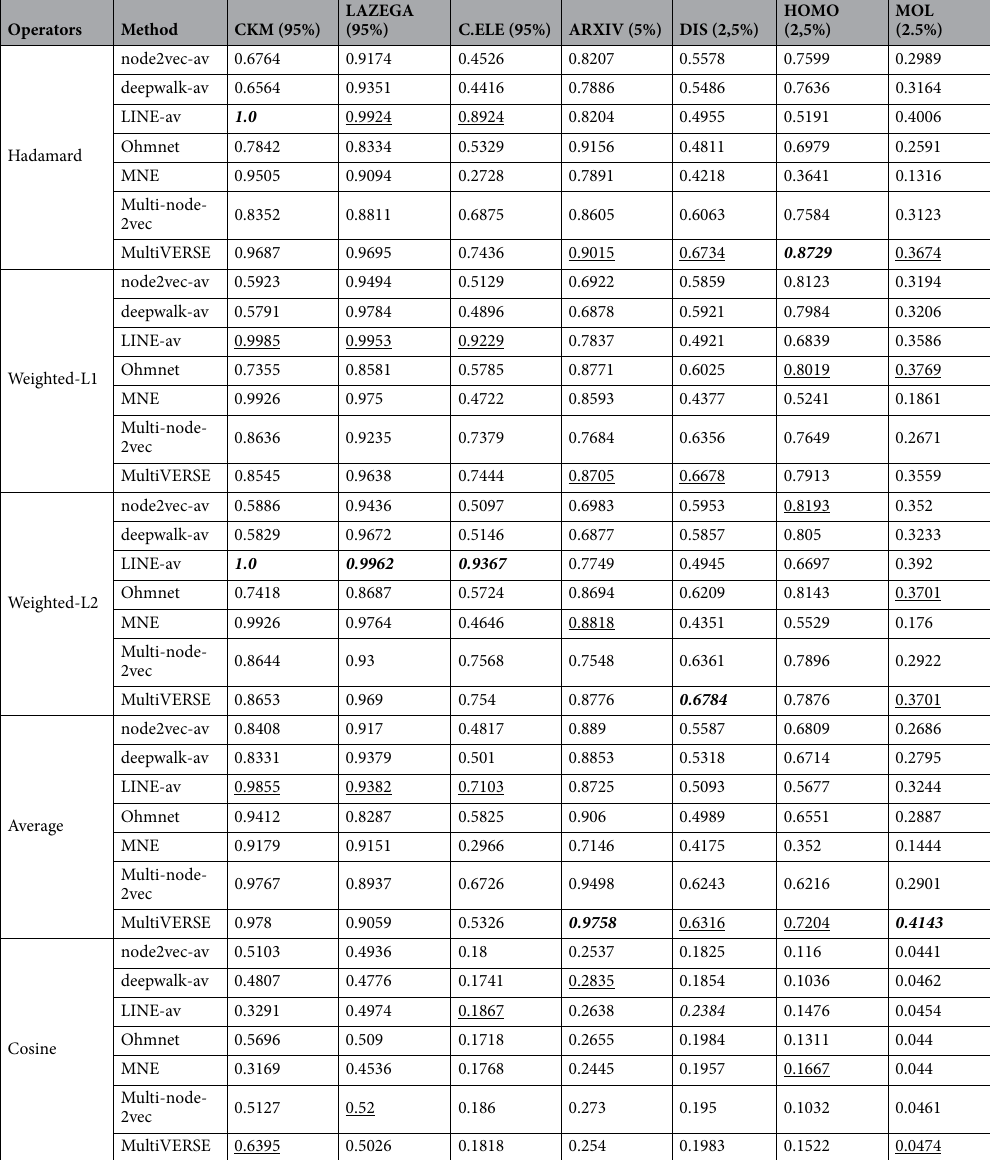
Table 5. precision@ K scores for network reconstruction on the 7 reference multiplex networks, for the network embedding methods combined with different embeddings operators (Hadamard, Weighted-L1, Weighted-L2, Average, and Cosine). For each multiplex network, the best score is in bold; for each operator, the best score is underlined. The percentage of edges used for the reconstruction is indicated in parenthesis under the name of the network. In the case of large networks (DIS, ARXIV, HOMO and MOL) MultiVERSE achieves the best performance in combination with different operators.